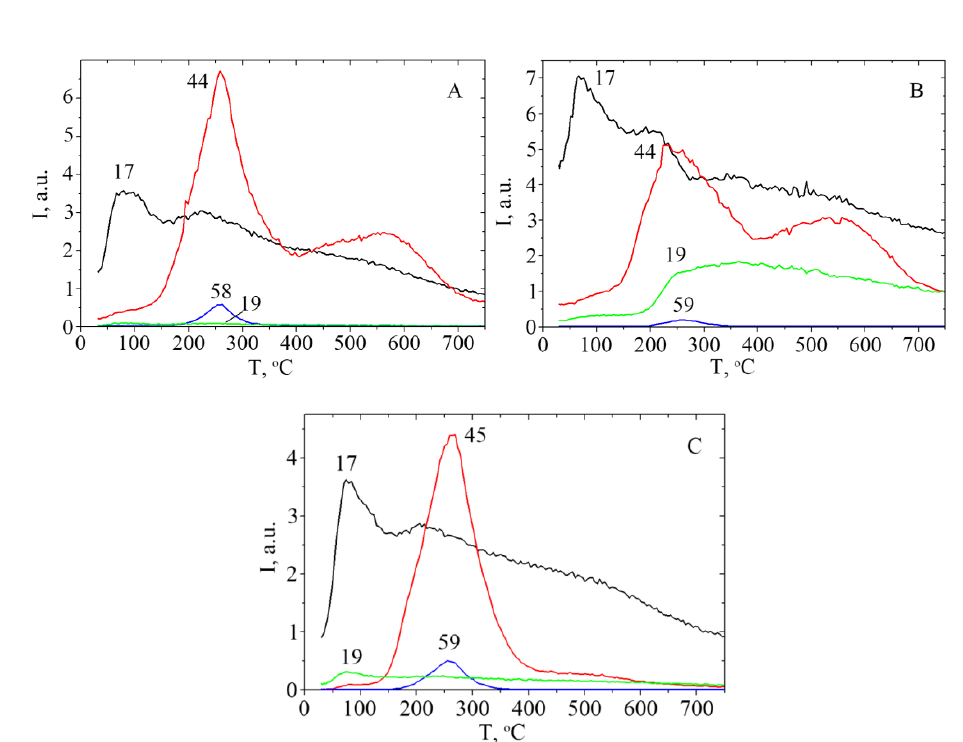
Figure 5. TPD curves for the molecular ion of acetone with m/z = 58, molecular ion of 13 C-labeled acetone with m/z = 59, molecular ion of CO 2 with m/z = 44, molecular ion of 13 CO 2 with m/z = 45, ion of H 3 O + with m/z = 19, fragment ion of deuterated water HDO with m/z = 19 and fragment ion of water with m/z = 17 were obtained during the pyrolysis of CH 3 COOH ( A ); CD 3 COOH ( B ); CH 313 COOH ( C ) on the hCeSi surface.